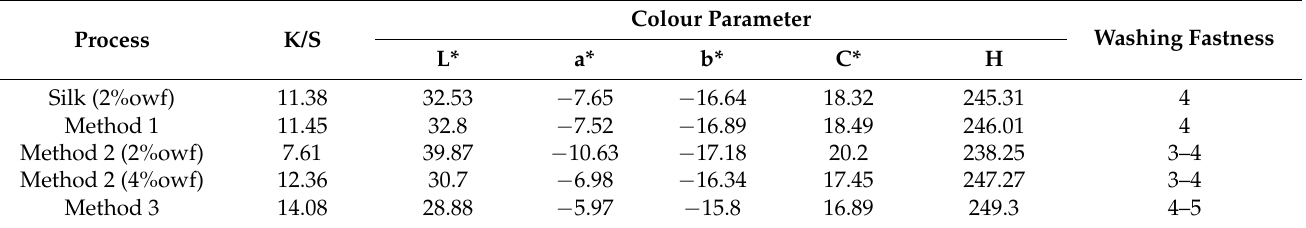
Table 6. K/S value, color parameters, and washing fastness of finished and control silk